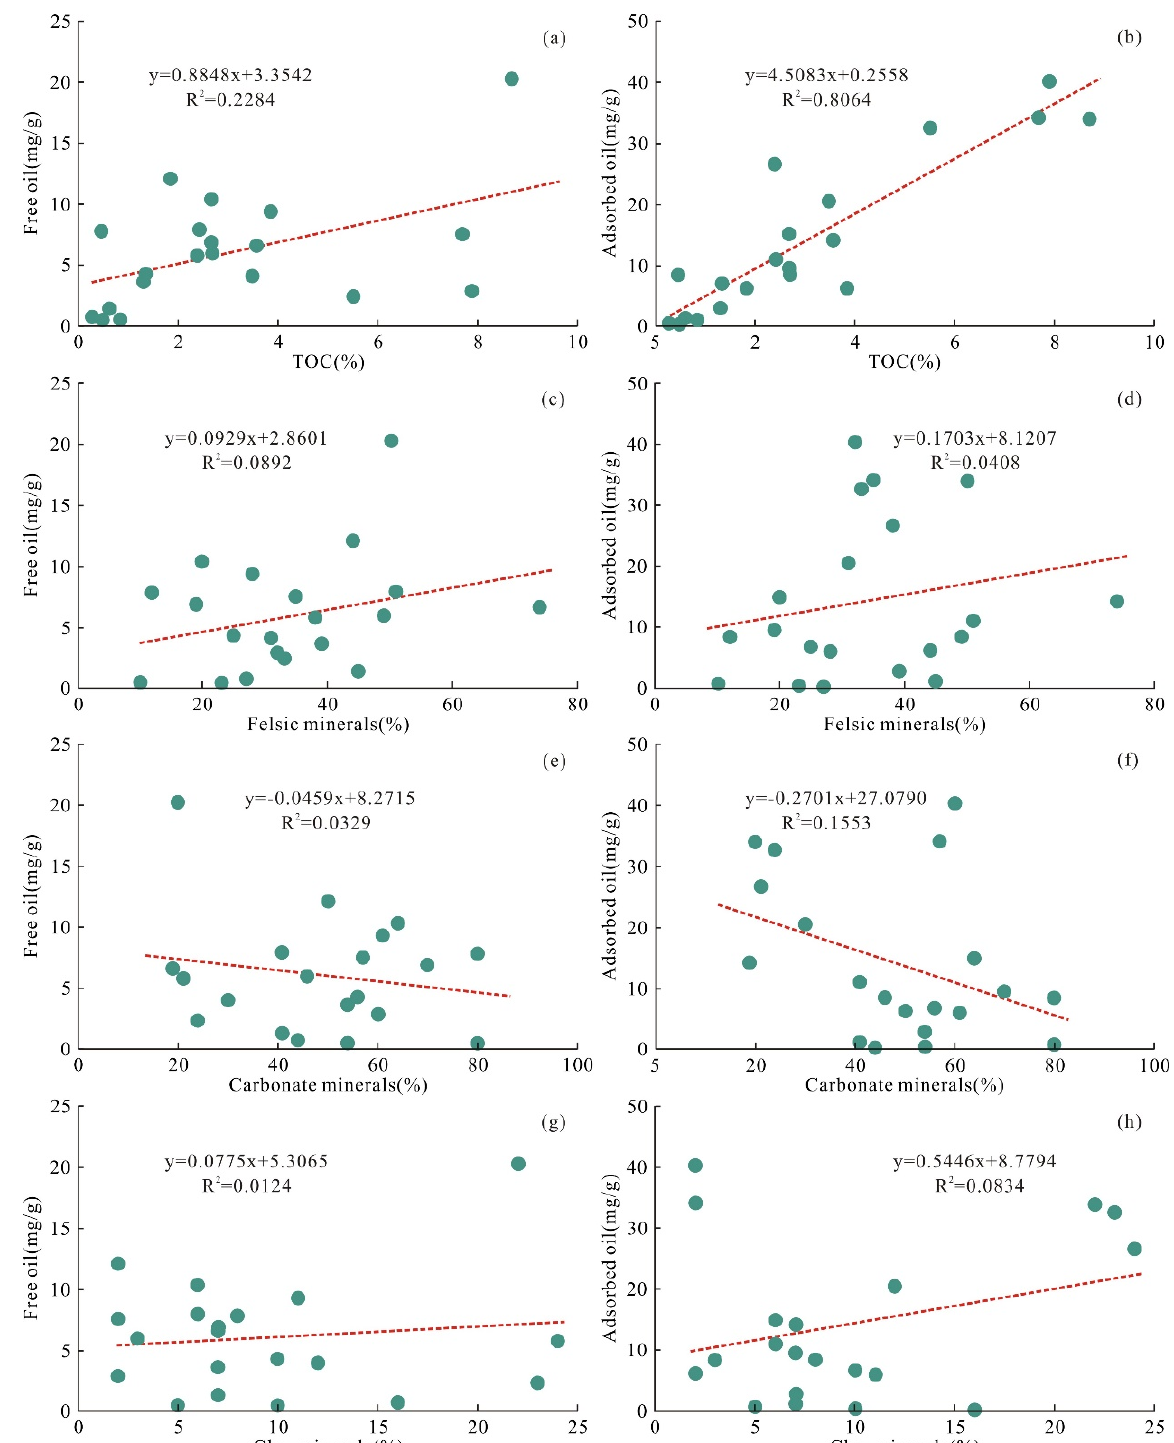
Figure 14. Correlations ( a ) between free oil and TOC, ( b ) between adsorbed oil and TOC, ( c ) between free oil and felsic minerals, ( d ) between adsorbed oil and felsic minerals, ( e ) between free oil and carbonate minerals, ( f ) between adsorbed oil and carbonate minerals, ( g ) between free oil and clay minerals, and ( h ) between adsorbed oil and clay minerals in the Ek 2 shale in the Cangdong Sag.